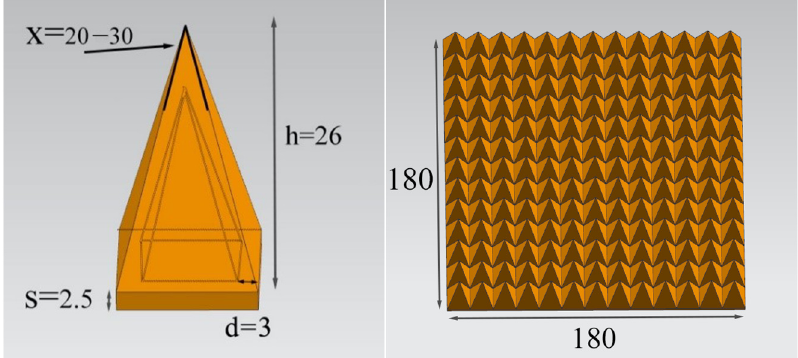
Figure 15. Parameters of the pyramid structure (unit: mm).